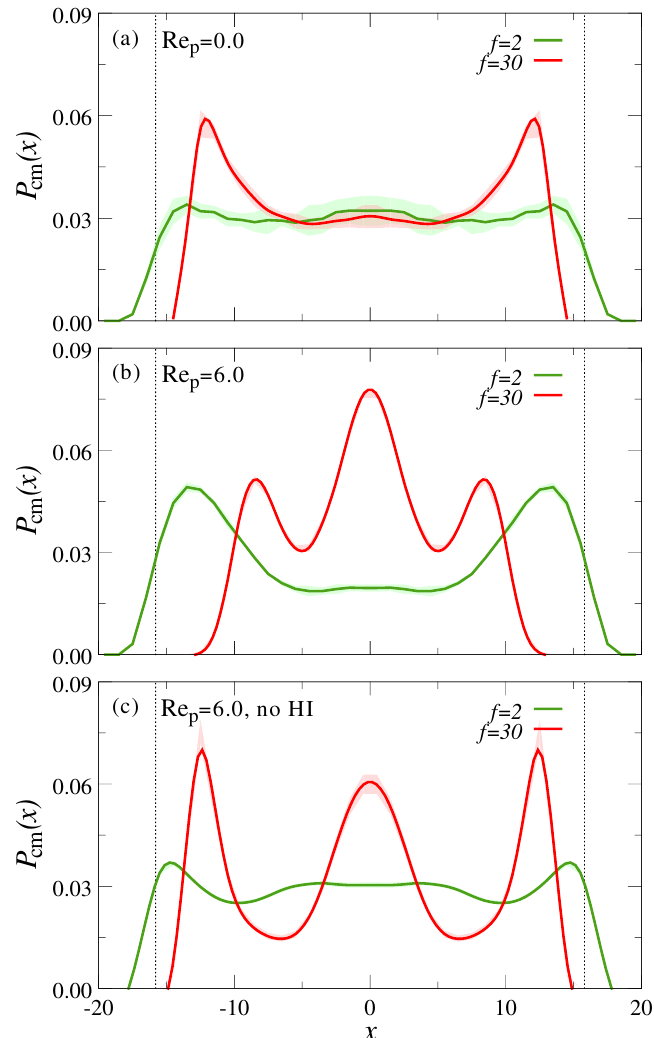
Figure 6. Center of mass probability distribution normal to the channel walls, P cm ( x ) , for a mixture of chains ( f = 2) and stars ( f = 30) at ( a ) rest (Re p = 0) and ( b ) under flow (Re p = 6). Panel ( c ) shows the system under flow (Re p = 6), but with hydrodynamic interactions switched off. The volume fraction of polymers is fixed to Φ = 0.1 in all